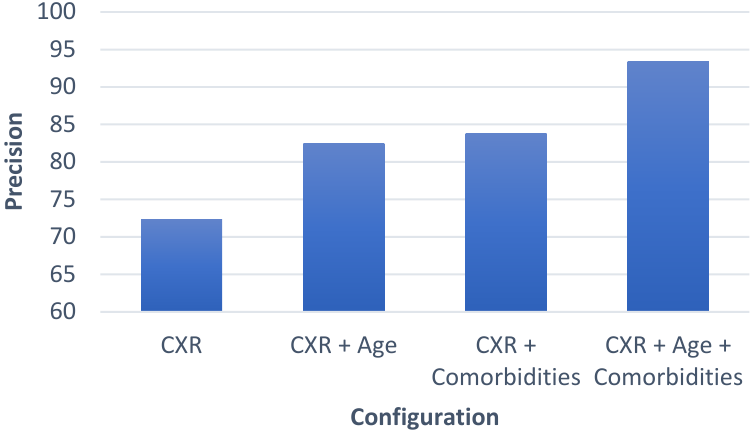
Figure 7. Effect of various parameters in case retrieval on severity prediction performance.